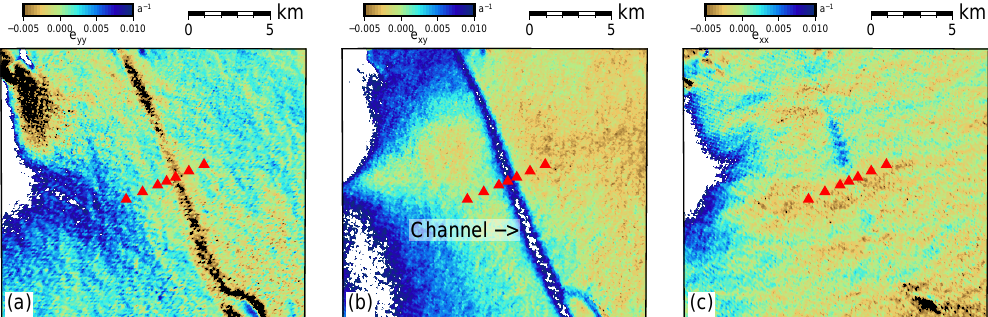
Figure 8. Strain rates inferred from ERS1/2 surface velocities on a 50m grid dating from 1996 (S. Berger, personal communication, 2014). All values are calculated in a local coordinate systems ( x along flow, y across flow). The ice-shelf channel is evident due to across-flow convergence in (a) and enhanced horizontal shearing in (b) , whereas along-flow extension remains inconspicuous (c) . The red triangles mark positions of GPS-derived flow velocities (Fig.